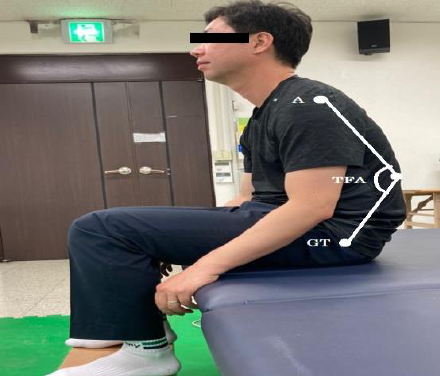
Figure 1. Measurement of trunk flexion angle. A: acromion, TFA: trunk flexion angle, GT: greater trochanter. Frontal plane asymmetry, commonly known as pelvic obliquity, in which one innominate bone is higher or lower than the other innominate [17], was calculated according to the angle between the horizontal plane defined by the global coordinate system of the motion capture volume and the line connecting both ASISs